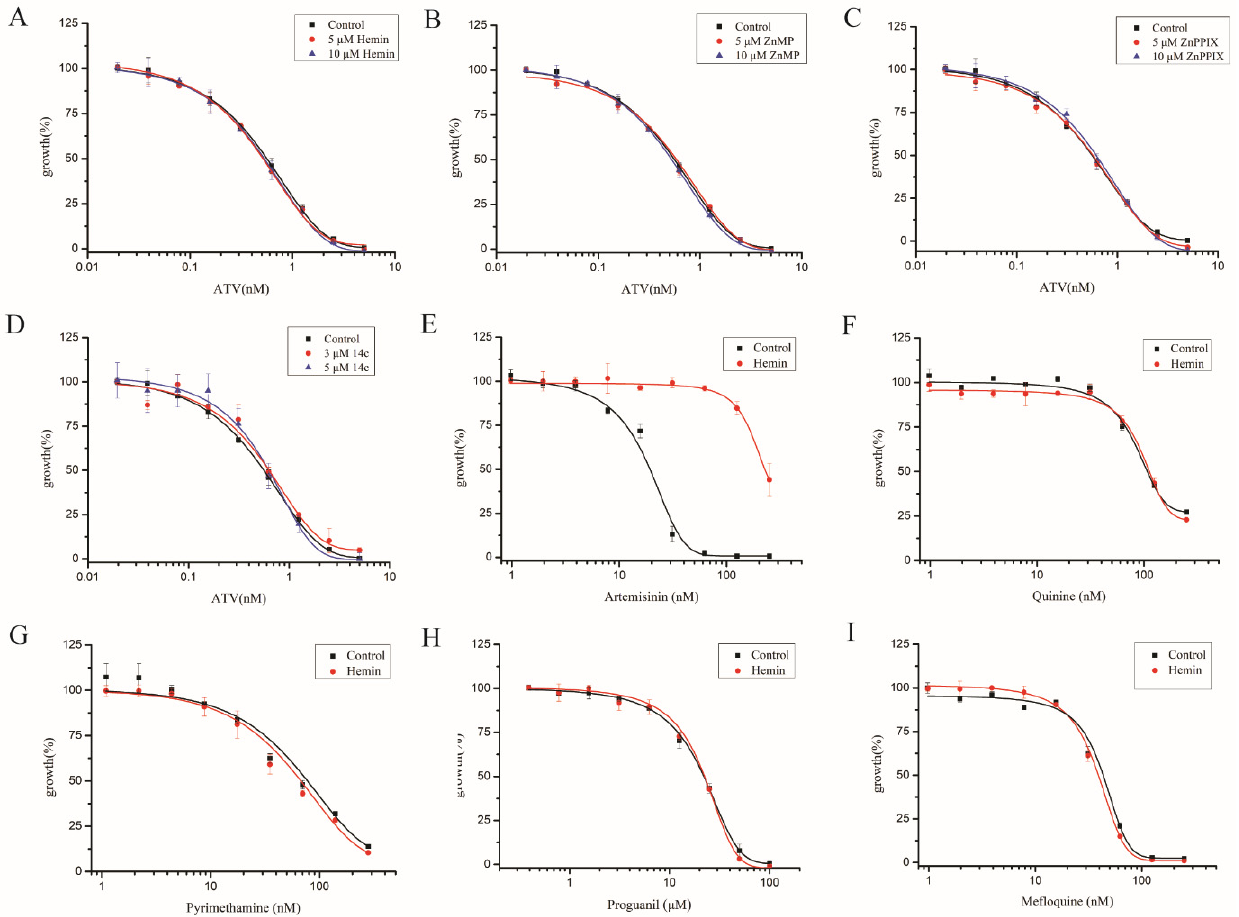
Figure 6. Heme had no effect on other antimalarial drugs. Parasites’ sensitivity to atovaquone had no significant change with 10 μ M hemin ( A ), ZnPPIX ( B ), ZnMP ( C ) and 14c ( D ). Hemin decreased the sensitivity of artemisinin ( E ) but not antimalarial drugs quinine ( F ), pyrimethamine ( G ), mefloquine ( H ) and proguanil ( I ). ATV: atovaquone. Data are mean ± SD of three experiments.